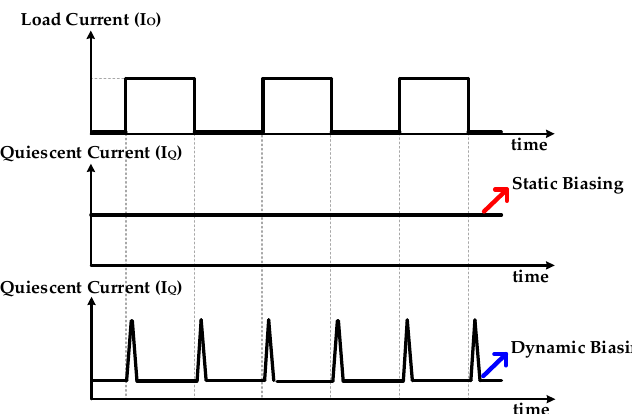
Figure 3. Relationship between output current and quiescent current of an LDO regulator.